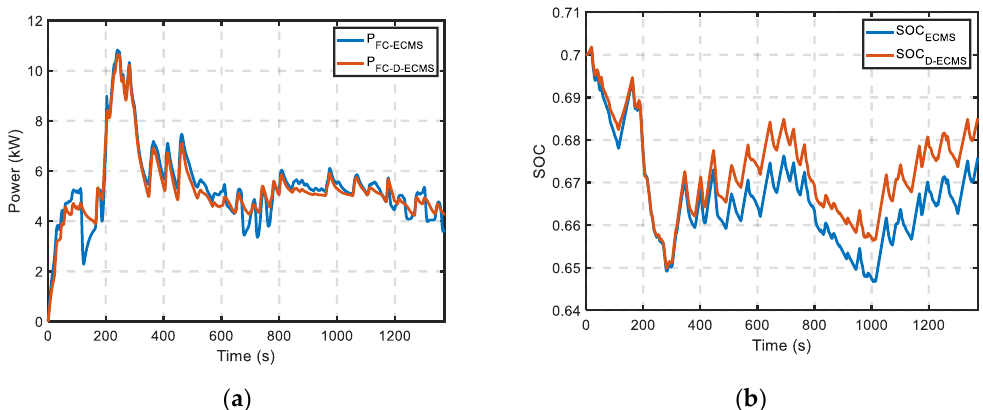
Figure 12. Vehicle simulation results for FTP-72 cycle: ( a ) Variation of fuel cell power according to energy management strategy; ( b ) variation of battery SOC according to energy management strategy.